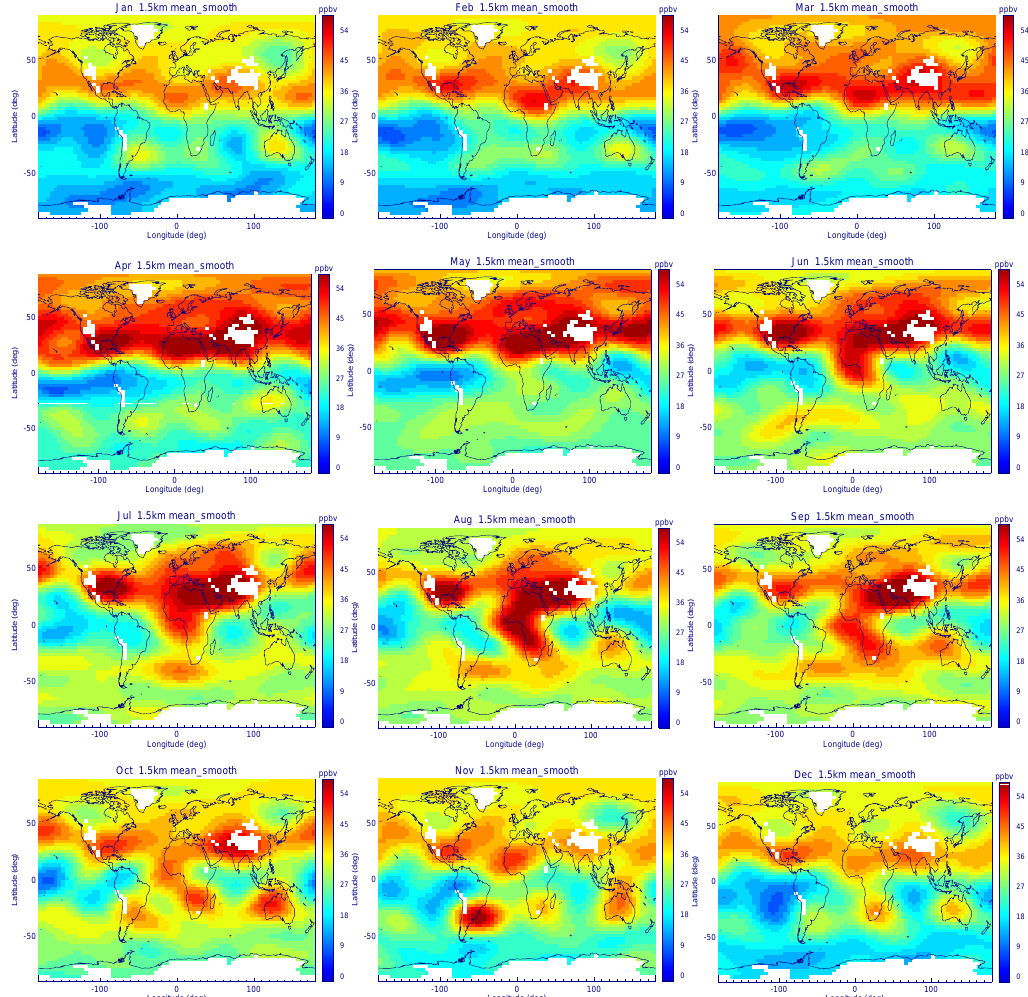
Figure 25. Monthly global ozone distributions at 1.5kma.s.l from trajectory-mapped ozone soundings (G. Liu et al., 2013). Fig. 6. Global ozone distributions at 1.5 km above sea level for all months. The trajectory-mapped results have been smoothed and further interpolated. Data from 1980 to 2008 are used.